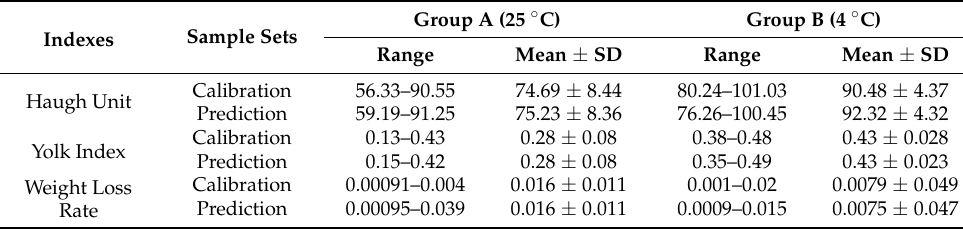
Table 3. Statistics of egg indexes in calibration and prediction samples sets.